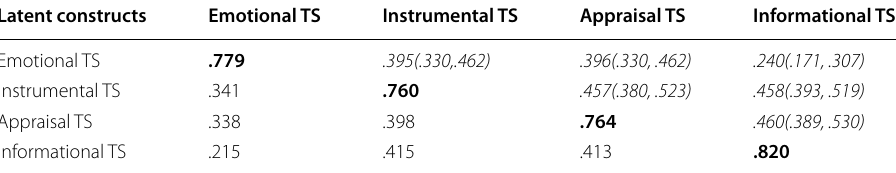
The values (in bold) on the diagonal are the square root of AVE values. The values below the diagonal show the correlations between the constructs. The values above the diagonal indicate the HTMT ratios with 95% CI shown in